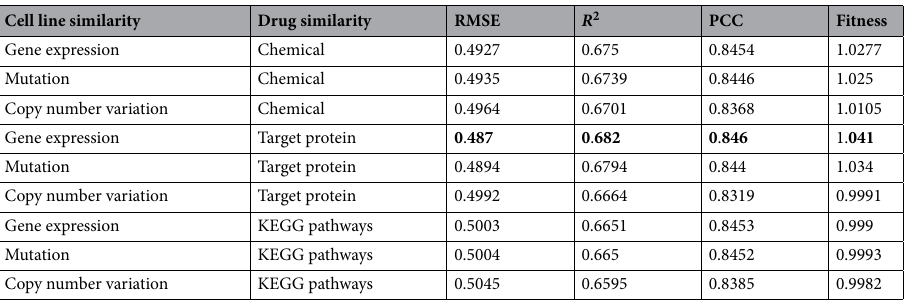
Table 2. Performance of ADRML on various types of similarities. The performance of each model is evaluated using fivefold cross-validation on cell line-drug pairs and using k = 70% , µ = 2 shows the performance of ADRML on a pair of cell line and drug similarity. The best results of each criteria is shown in bold face.